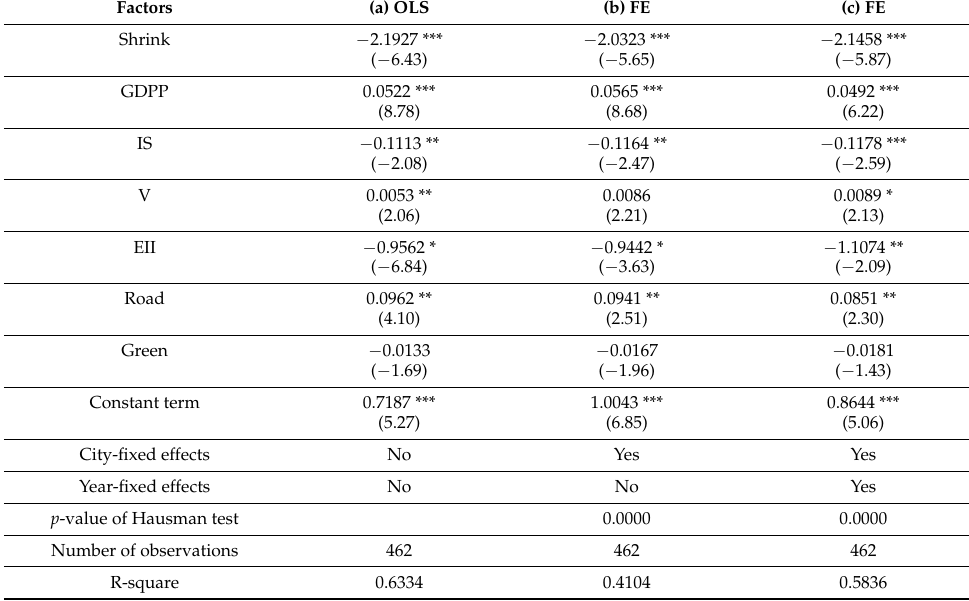
Table 4. The regression